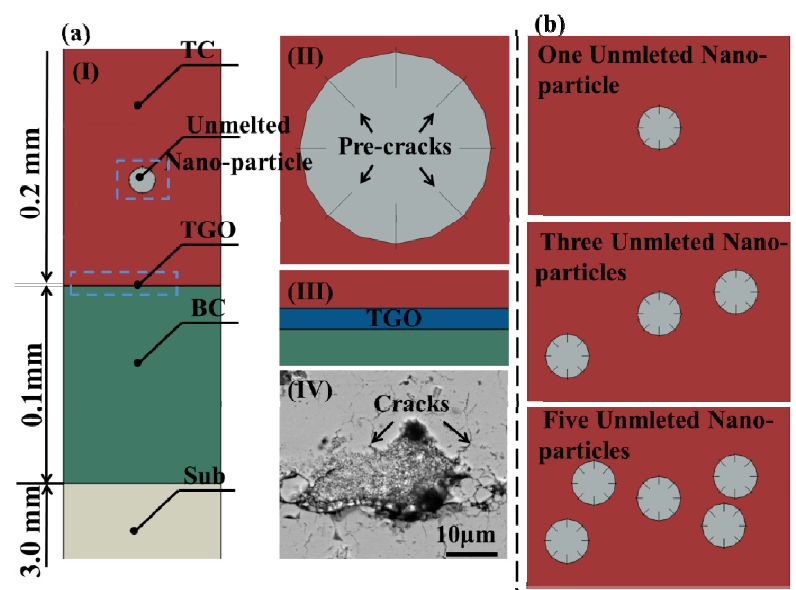
Figure 3. Crack propagation model of TBCs. ( a ) All the layers of TBCs; a detailed view of UNP with